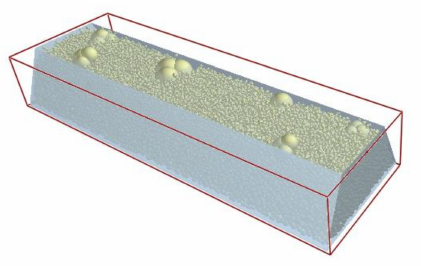
Figure 10. Trapezoid